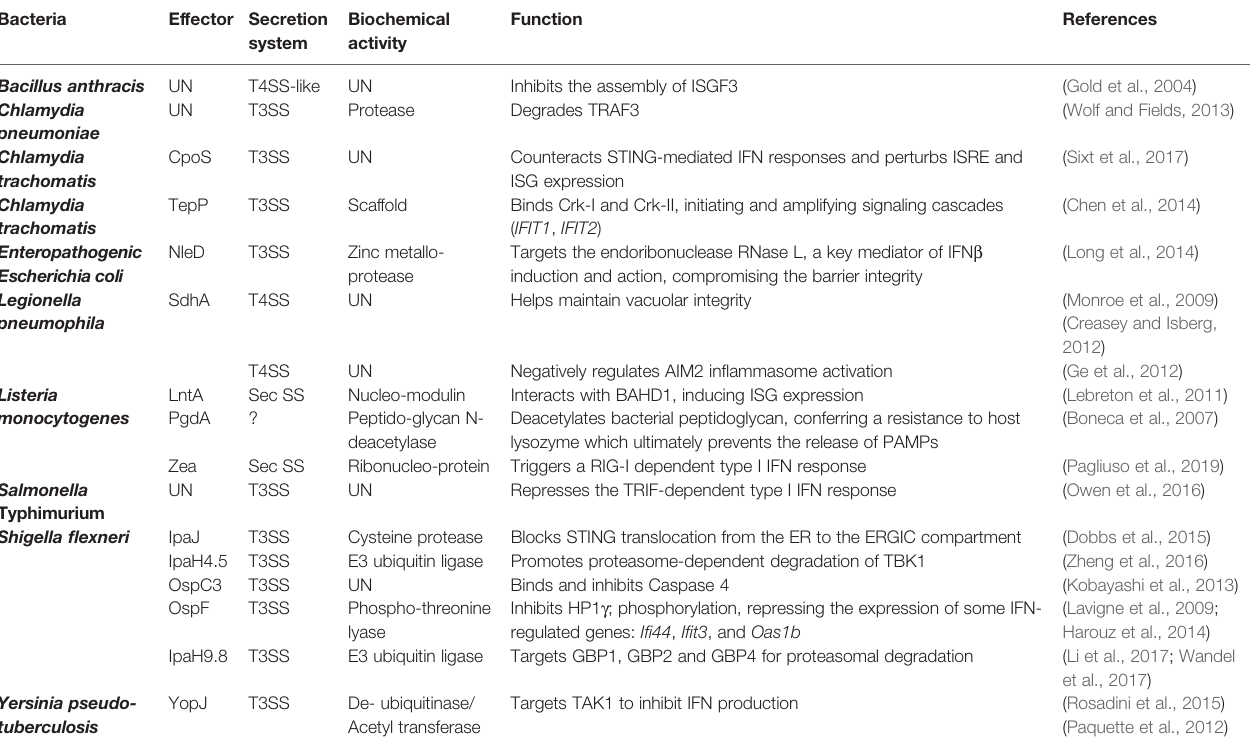
TABLE 1 | Summary of effectors that target IFN pathways.